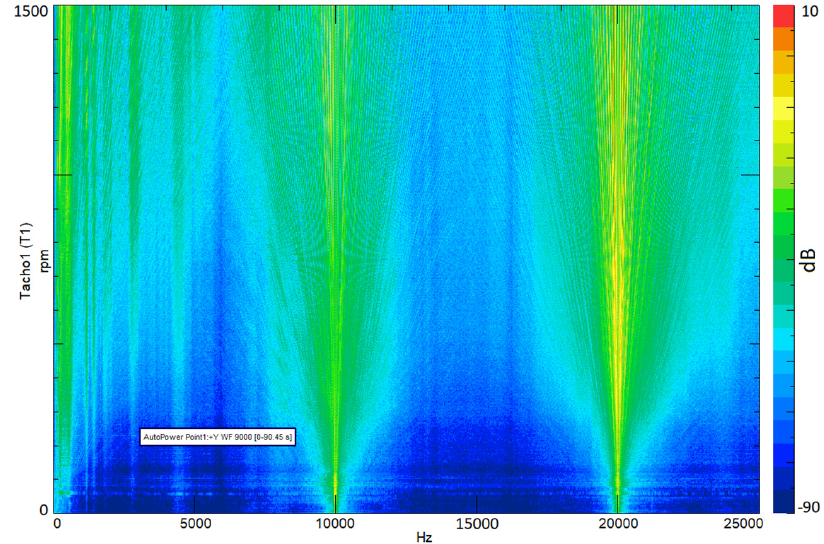
Figure 13. Vibration measured at 10 kHz switching frequency .